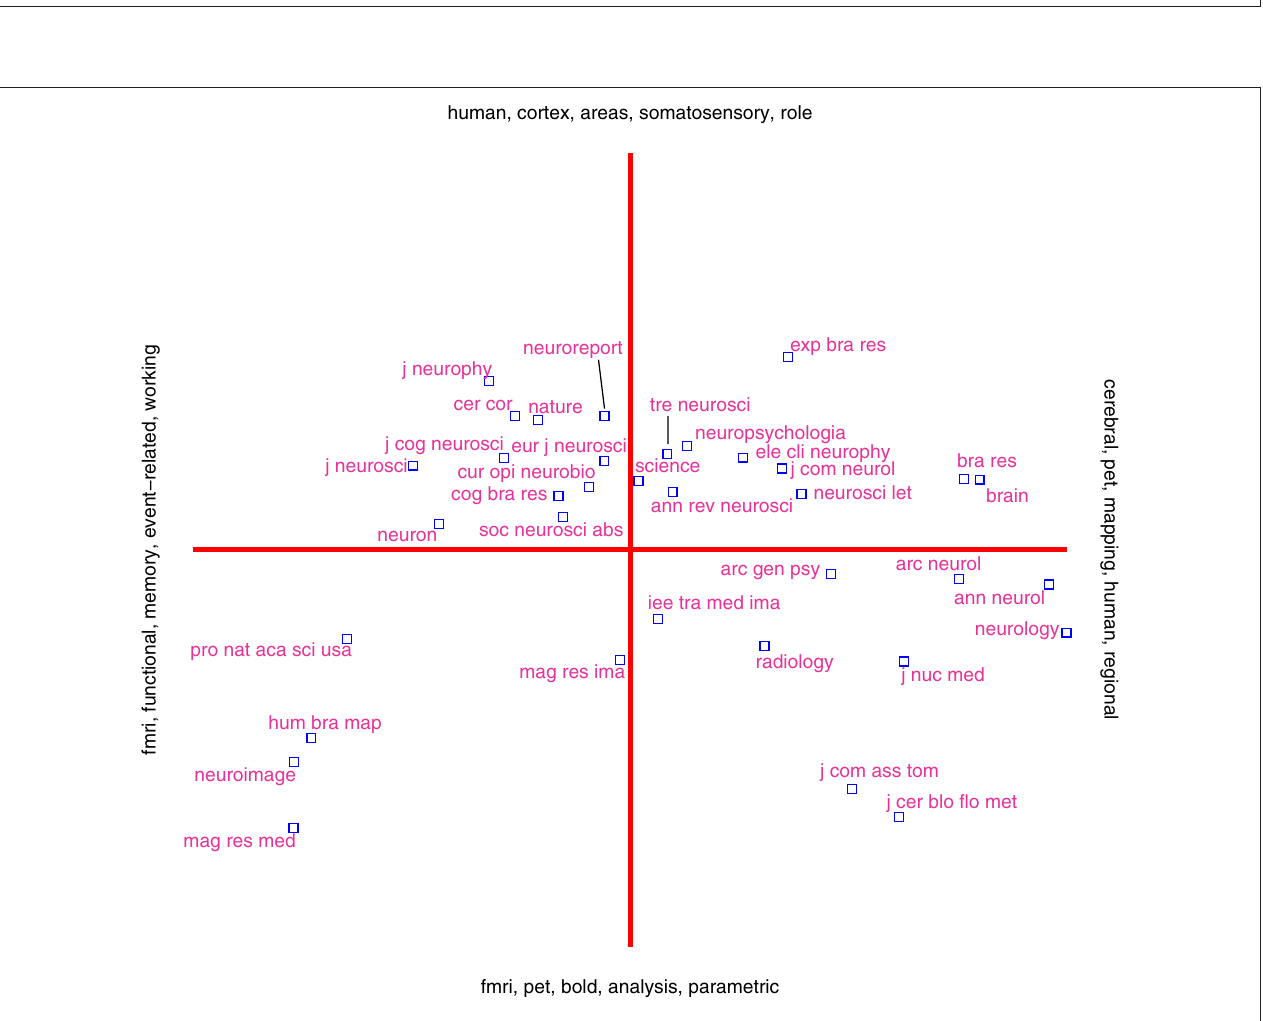
FIGURE 11 | Visualization of data mining result of journal co-citation analysis with singular value decomposition on citation data from